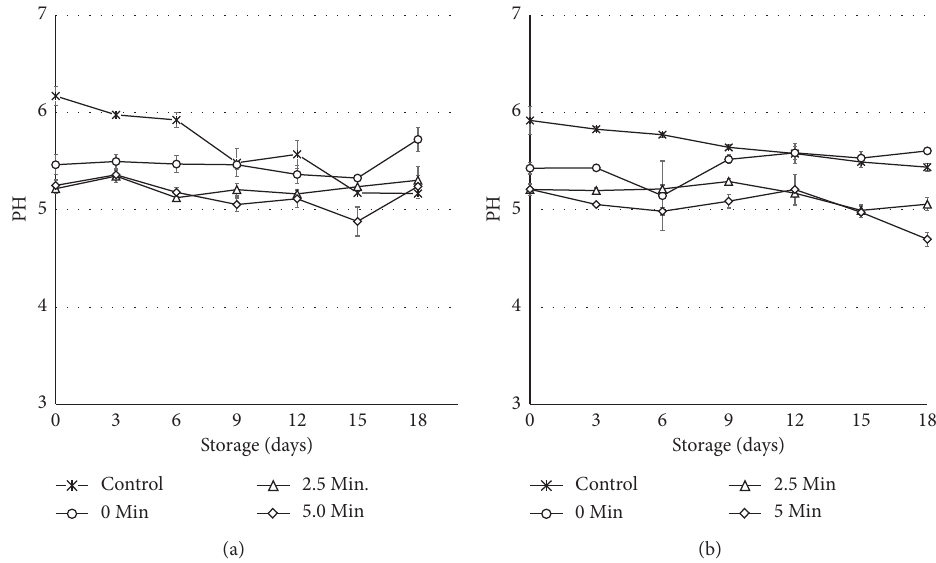
Figure 5: Immersion time effect on pH values during storage of papaya cubes treated. Control (a) and E . coli treated cubes